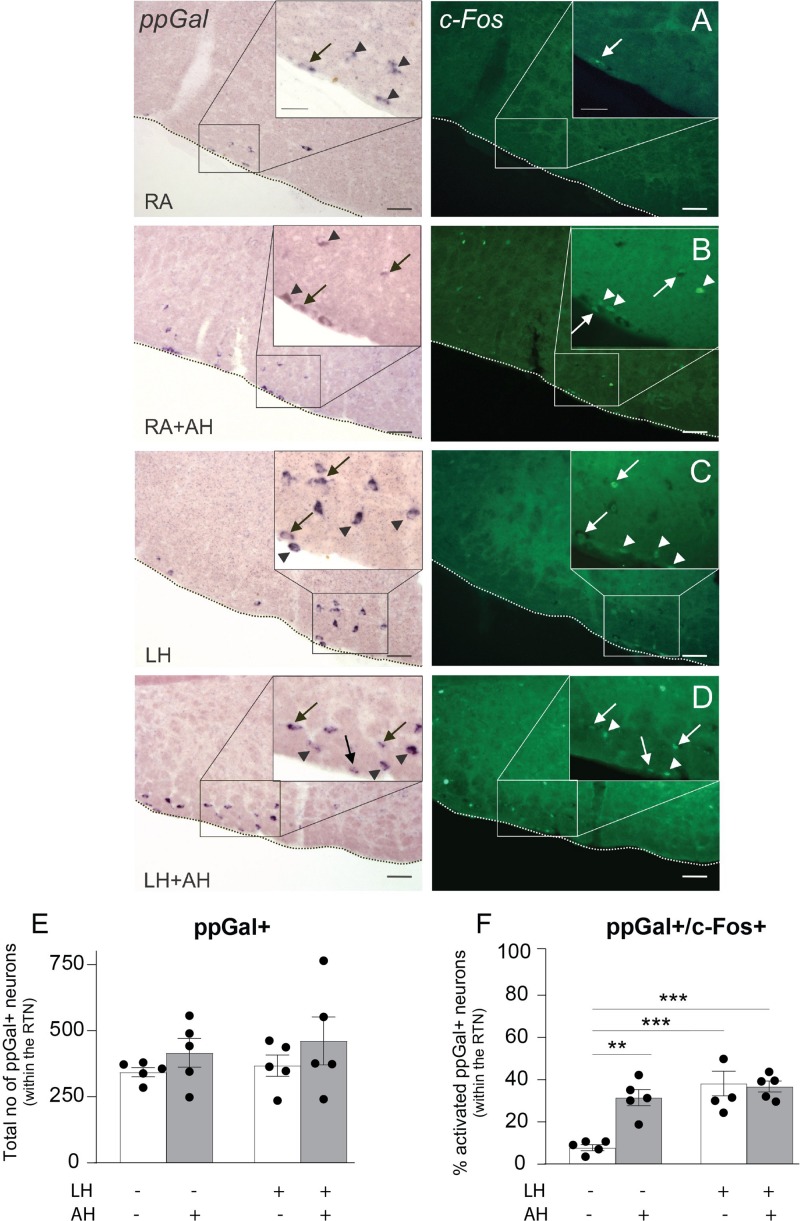
The ppGal+ neurons in the RTN do not change their responsiveness to acute hypercapnic chemoreflex challenge after a long-term exposure to hypercapnia. Representative images of the coronal brainstem sections from the RTN region showing the activation of the galaninergic RTN neurons following (A) room air (RA), (B) room air + acute hypercapnia chemoreflex challenge (RA + AH), (C) long-term hypercapnia (LH), (D) long-term hypercapnia + acute hypercapnia chemoreflex challenge (LH + AH). ppGal+ neurons are purple (alkaline phosphatase ISH labeled neurons) and c-Fos+ neurons are in green (IHC). The box in each panel is enlarged for a higher magnification representation of the area. Arrowheads point to single labeled neurons; arrows point to activated ppGal+ RTN neurons. Scale bars are 50 μm in low magnification images and 25 μm in high magnification images. (E) The total number of ppGal+ RTN neurons per mouse. (F) The percentage of activated ppGal+ neurons of total ppGal+ neurons within the RTN following different challenge conditions. ∗∗p < 0.01, ∗∗∗p < 0.001 (Two-Way ANOVA, Multiple comparisons: Sidak).